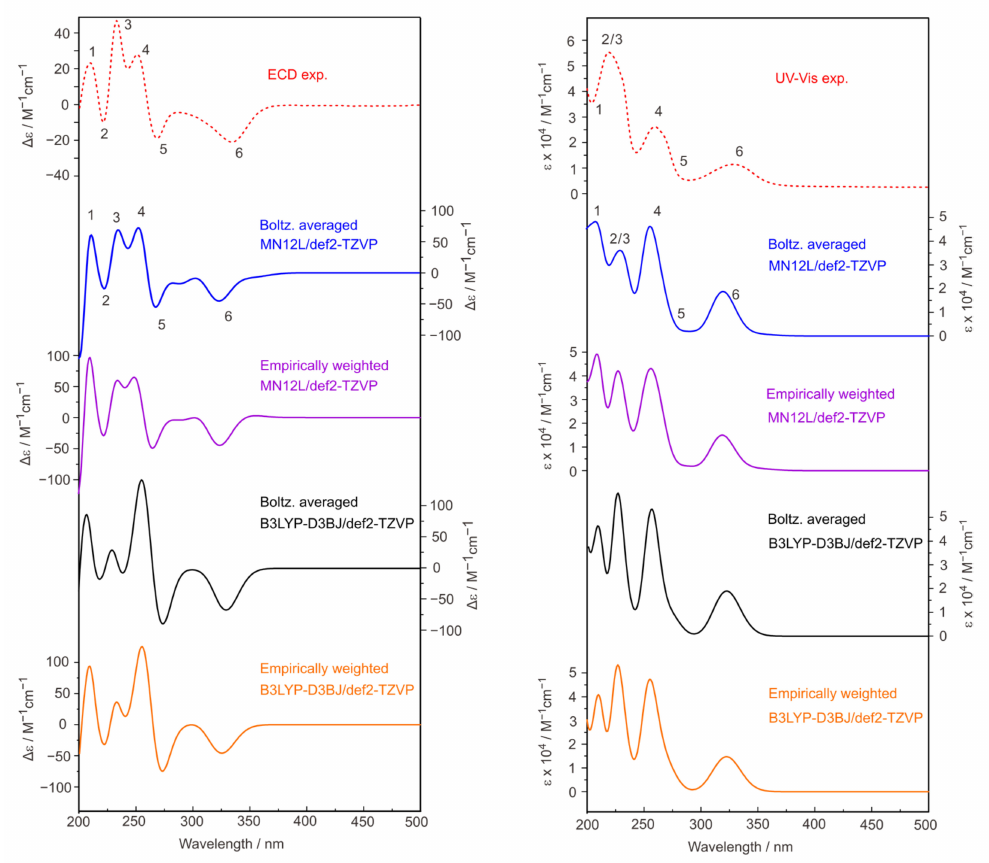
Figure 6. Comparison of the experimental and theoretical UV-Vis and ECD spectra of salen-chxn in acetonitrile solution. The first 200 electronic states were included in the calculations at the two levels of theory indicated. For the empirically weighted spectra, we used the same weights derived from the IR and VCD comparison. The main UV-Vis and ECD bands are labelled as “1” to “6” to aid the